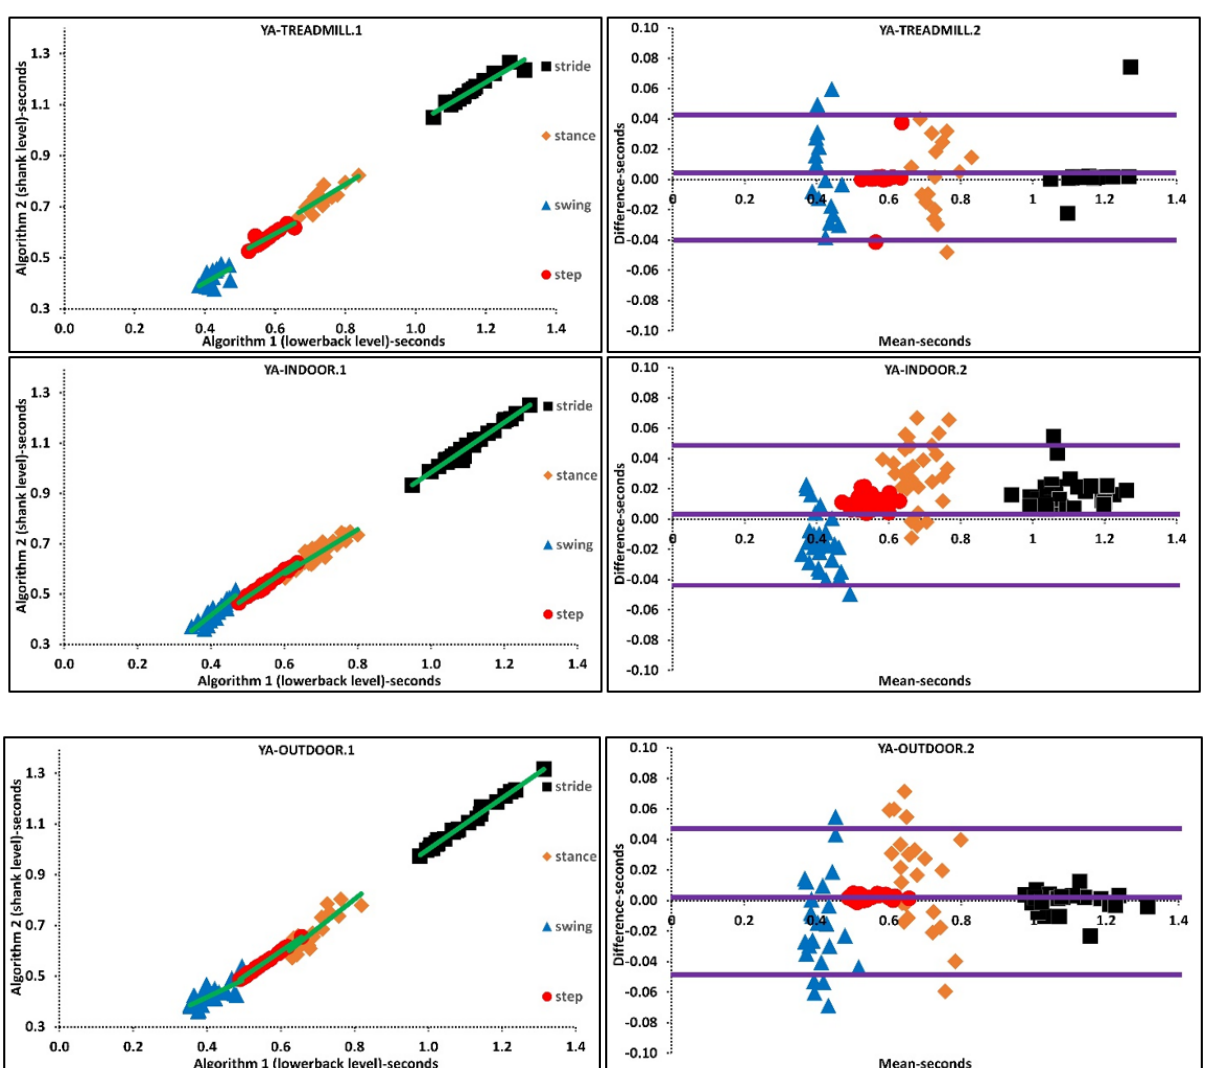
Figure 3. Scatter and Bland-Altman plots of algorithms 1 and 2 for investigating the agreements in various walking environments by pooling all temporal parameters. TREADMILL.1, INDOOR.1, OUTDOOR.1 are scatter plot with regression line (green), respectively. TREADMILL.2, INDOOR.2, OUTDOOR.2 are Bland-Altman plotting with mean, lower and upper bands (purple), respectively.